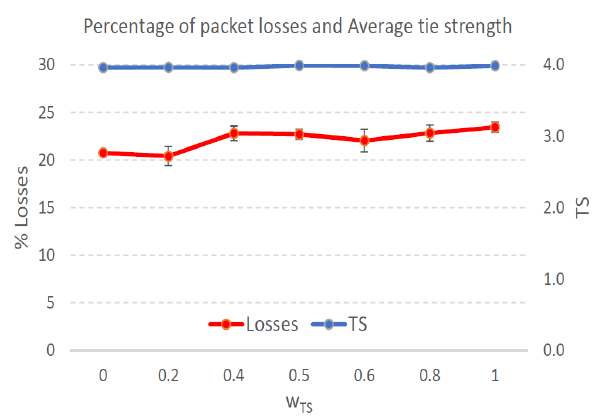
Figure 16. Percentage of packet losses and average tie strength of the forwarding path. Scenario with very high social media interaction (TS normal distribution with µ = 4 and σ = 1). Nodes’ density = 100 nodes/km 2 .